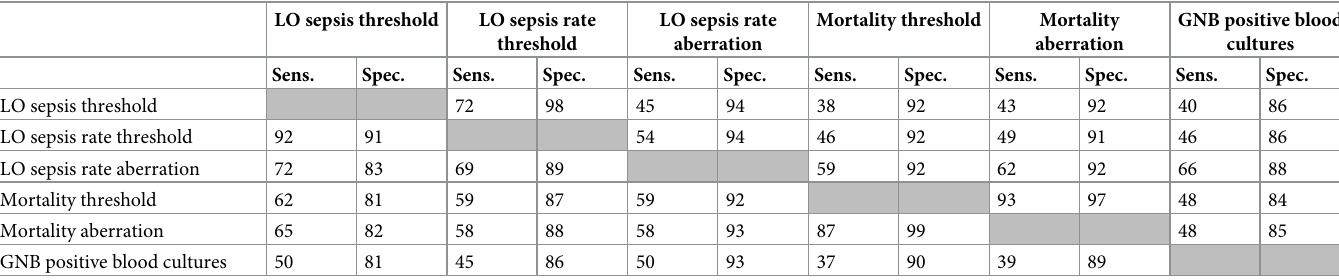
Table 4. Sensitivity (Sens.) and specificity (Spec.) of pairs of alarm indicators.